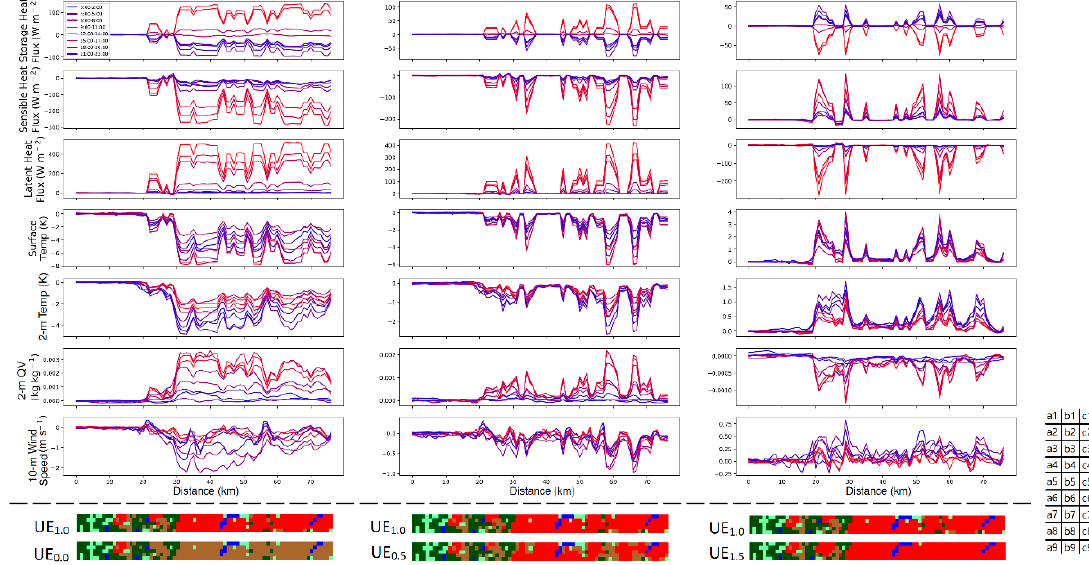
Figure 6. Average difference in ( 1 ) storage heat flux; ( 2 ) turbulent sensible heat flux at the surface; ( 3 ) turbulent latent heat flux at the surface; ( 4 ) surface temperature; ( 5 ) 2 m air temperature; ( 6 ) 2 m specific humidity; ( 7 ) 10 m wind speed, with changes in urban extent UE 1.0 and ( a ) UE 0.0 , ( b ) UE 0.5 , ( c ) UE 1.5 scenarios (Section 2.5) along cross-sections (location: Figure 3a) for eight 3 h periods (averaged 2 to 5 July 2013 local standard time LST); and land use of the cross-section for ( 8 ) before case and ( 9 ) after case (see also Figure 3c ).